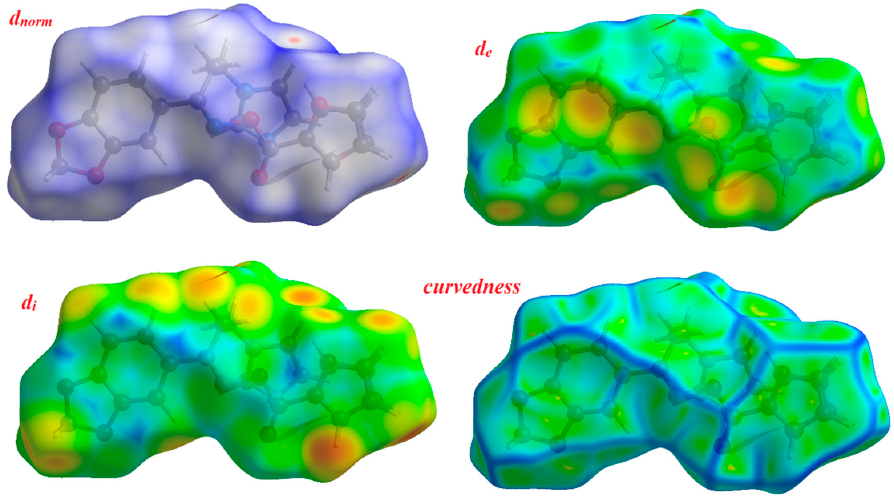
Figure 4. Hirshfeld surfaces for d norm , d i , d e and curvedness for the oximino ester 5 .